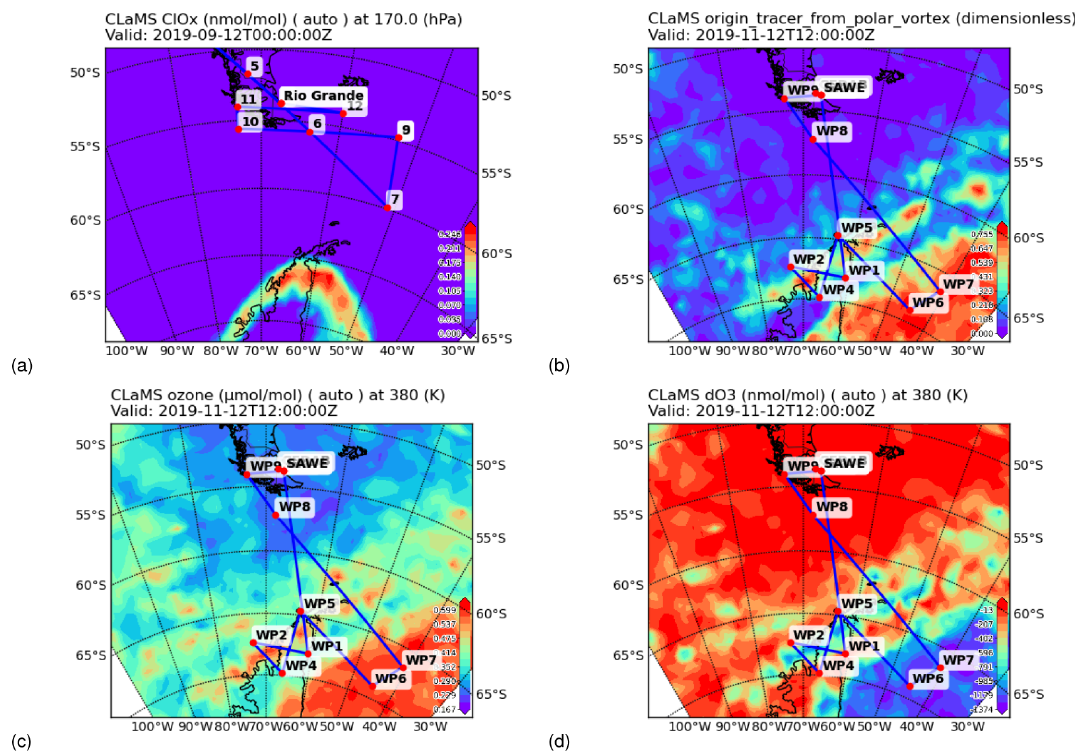
Figure 8. Chemistry-related plots: active chlorine ClOx for flight ST08 (a) ; the origin tracer from polar vortex for flight ST25 (b) ; ozone mix- ing ratio (c) ; and simulated accumulated ozone depletion (dO 3 ) (d) . Panel (a) is in cylindric projection, while the others are in stereographic projection. Panels (c) and (d) also show the borders of the Flight Information Regions (FIR) as green lines (kml overlay).